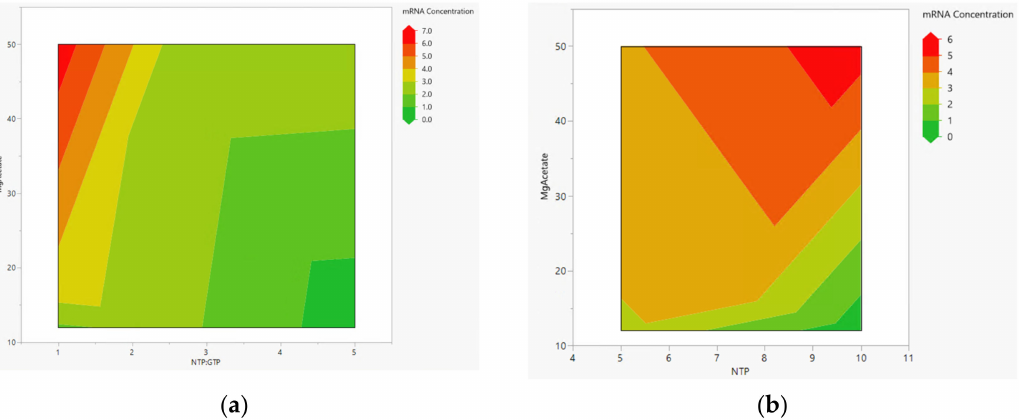
Figure 16. Design spaces based on reduced p -value model; ( a ) magnesium acetate and NTP:GTP and ( b ) magnesium acetate and NTP concentration.